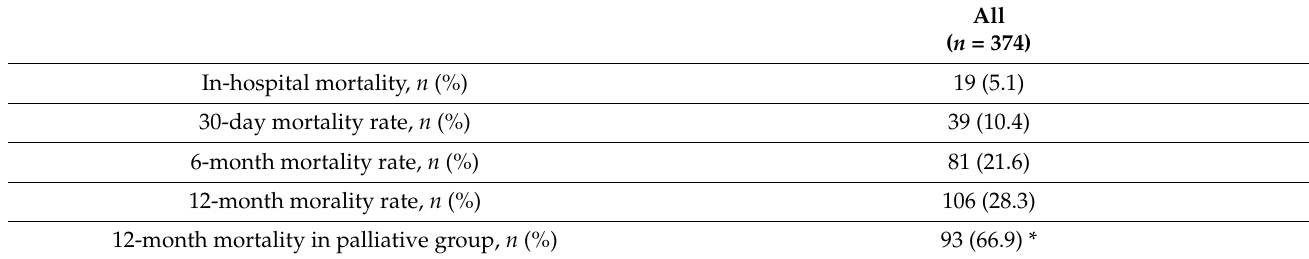
Table 5. Cumulative follow-up mortality